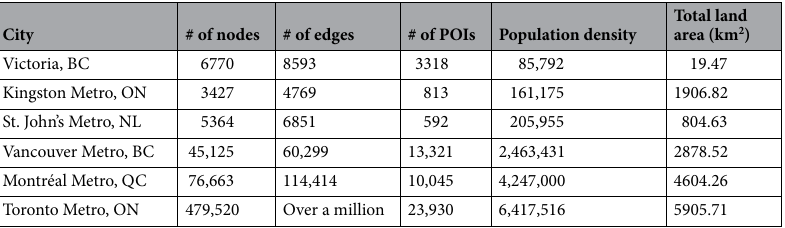
Table 1. List of road networks for various cities with their network and POI sizes that have been experimented with in this research. For brevity, in this paper we mostly focus on 3 cities of Kingston, Vancouver and Montréal. Nodes and edges are extracted from road networks. Population density and the total land area information are excerpted from